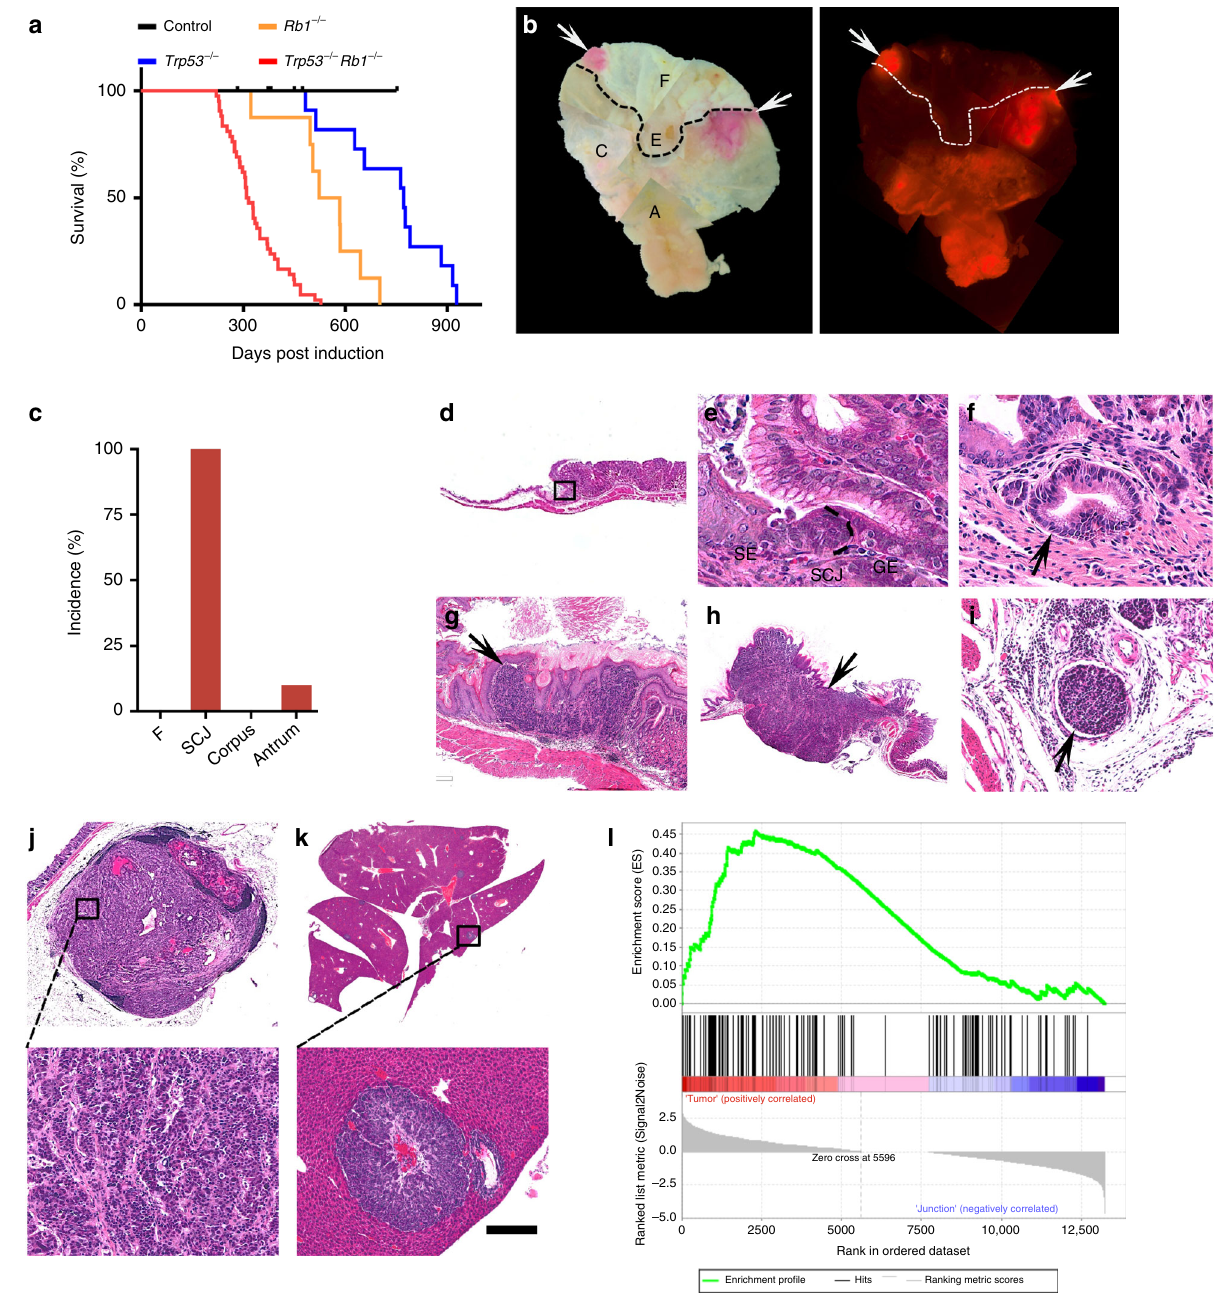
Fig. 1 Inactivation of Trp53 and Rb1 in Lgr5 + cells leads to preferential neoplasia at the gastric SCJ. a Kaplan – Meier survival curves of Lgr5 eGFP − Ires − CreERT2 Trp53 loxP/loxP Rb1 loxP/loxP Ai9 mice with ( Trp53 − / − Rb1 − / − , n = 42) and without (Control, n = 9) tamoxifen treatment (log-rank test P < 0.0001), and Lgr5 eGFP − Ires − CreERT2 Trp53 loxP/loxP Ai9 ( Trp53 − / − , n = 11) mice and Lgr5 eGFP − Ires − CreERT2 Rb1 loxP/loxP Ai9 mice ( Rb1 − / − , n = 8) treated with tamoxifen ( P < 0.001 vs Trp53 − / − Rb1 − / − mice for both Trp53 − / − and Rb1 − / − ). b tdTomato-expressing (tdTomato + ) neoplastic masses (red, arrows) in the stomach of Lgr5 eGFP − Ires − CreERT2 Trp53 loxP/loxP Rb1 loxP/loxP Ai9 mouse 291 days post induction (p.i.) with tamoxifen. Bright fi eld (left) and fl uorescence (right). The punctate lines indicate SCJ line. F forestomach, E esophagus, C corpus, A antrum. c Distribution of neoplasms in stomach regions ( n = 20). d , e SCJ between the squamous (SE) and glandular (GE) epithelium in adult Lgr5 eGFP − Ires − CreERT2 Trp53 loxP/loxP Rb1 loxP/loxP Ai9 mouse without tamoxifen induction. Rectangle in d indicates area shown in e . SCJ carcinogen e sis in Lgr5 eGFP − Ires − CreERT2 Trp53 loxP/loxP Rb1 loxP/loxP Ai9 mice includes dysplastic glandular lesions ( f , arrow, 120 days p.i.), early carcinoma ( g , arrow, 177 days p.i.), and advanced carcinoma ( h , arrow, 239 days p.i.) with vascular invasion ( i ). Preferent i al location of SCJ carcinoma metastases in the lymph node ( j , 20% of cases) and the liver ( k 35% of cases). Rectangle in top images indicates areas shown in bottom images. l Gene Set Enrichment Analysis of RNA-seq data of mouse gastric SCJ cancers ( n = 5) using human gastroesophageal cancer signature genes 70 . Enrichment score (ES) = 0.46, normalized enrichment score (NES) = 1.38, false discovery rate (FDR) q value = 0.08, P < 0.05. d – k Hematoxylin and eosin staining. Scale bar in k represents 3 mm ( b ), 1 mm ( d and h ), 60 μ m ( e ), 40 μ m ( f ), 300 μ m ( g ), 100 μ m ( i ), 600 μ m ( j top panel), 100 μ m ( j bottom panel), 4.5 mm ( k top panel), and 175 μ m ( k bottom panel). Source data are provided as a Source Data fi